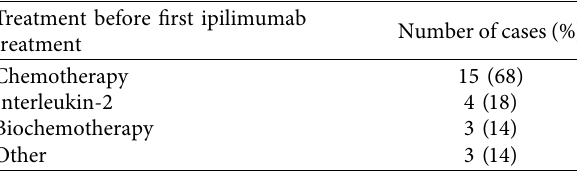
Table 4: Treatments before ipilimumab.